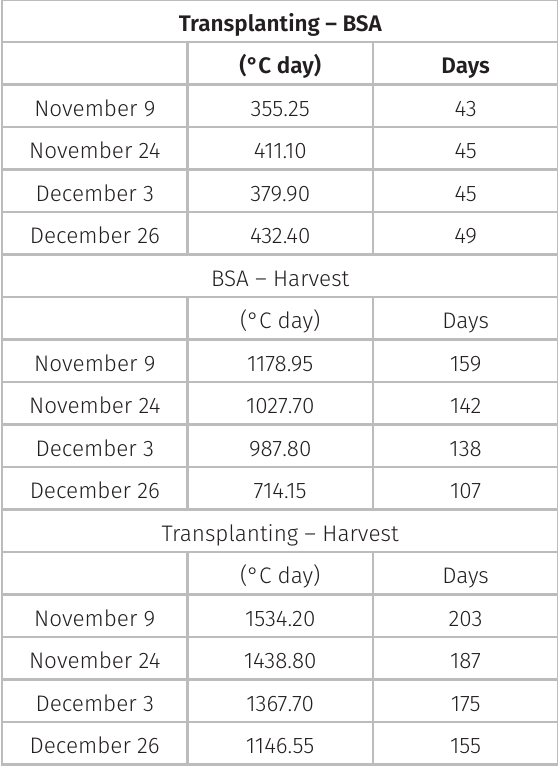
Table V. Accumulated thermal summation (°C day) and in days of stages from transplanting to the beginning of starch accumulation (BSA), BSA to harvest, and transplanting to harvest of cassava plants at four transplanting seasons (November 9 and 24 and December 3 and